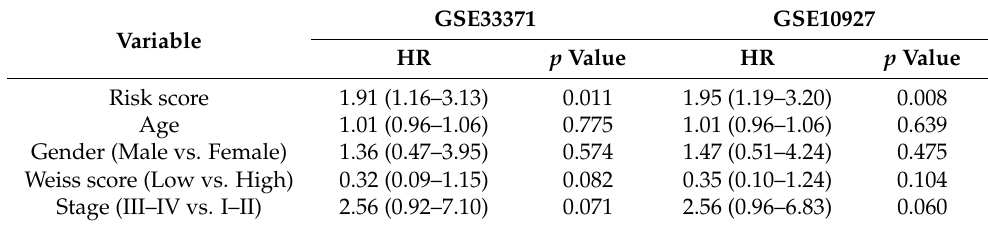
Table 2. The results of univariate Cox analyses in two external